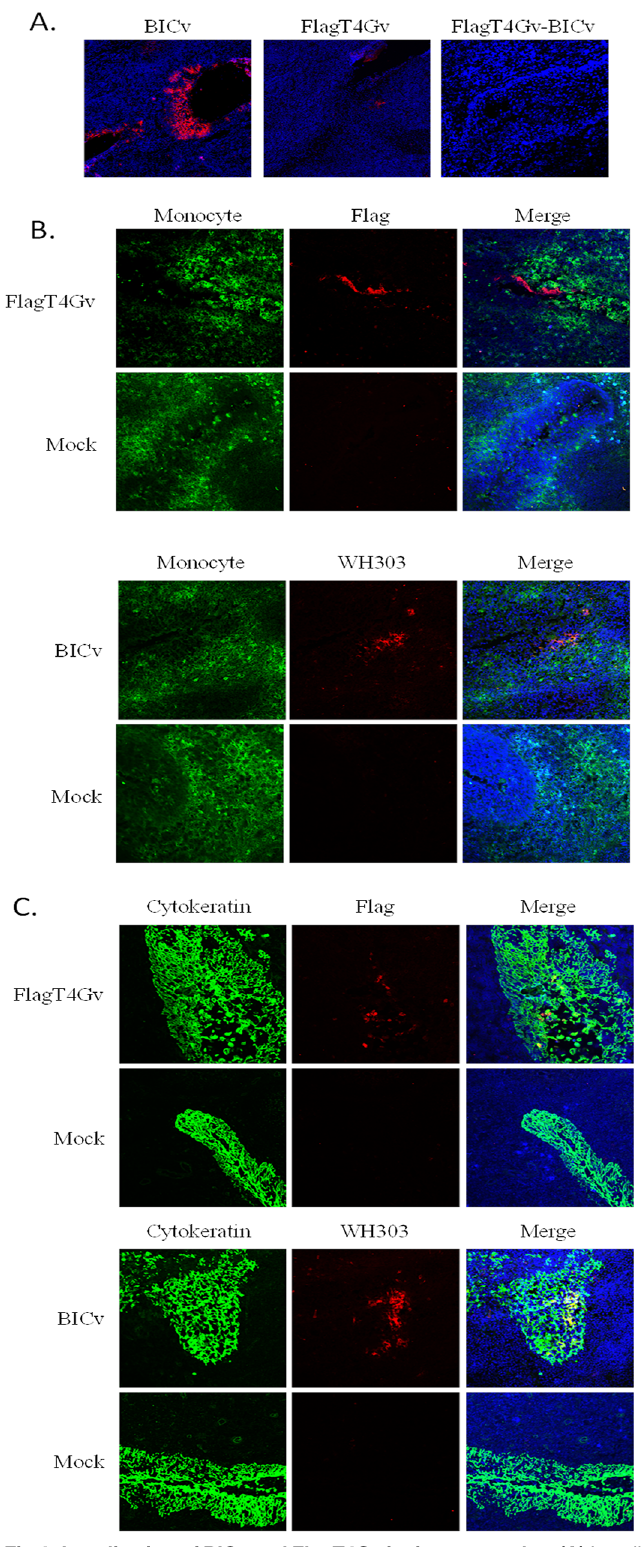
Fig 4. Localization of BICv and FlagT4Gv in tissue samples. (A) Localization of BICv and FlagT4Gv in frozen sections of tonsil tissues from pigs either IM infected with FlagT4Gv or IN with BICv. Cryosectioned